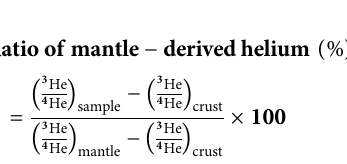
FIGURE 1 | Genetic types of helium in major onshore petroliferous basins in